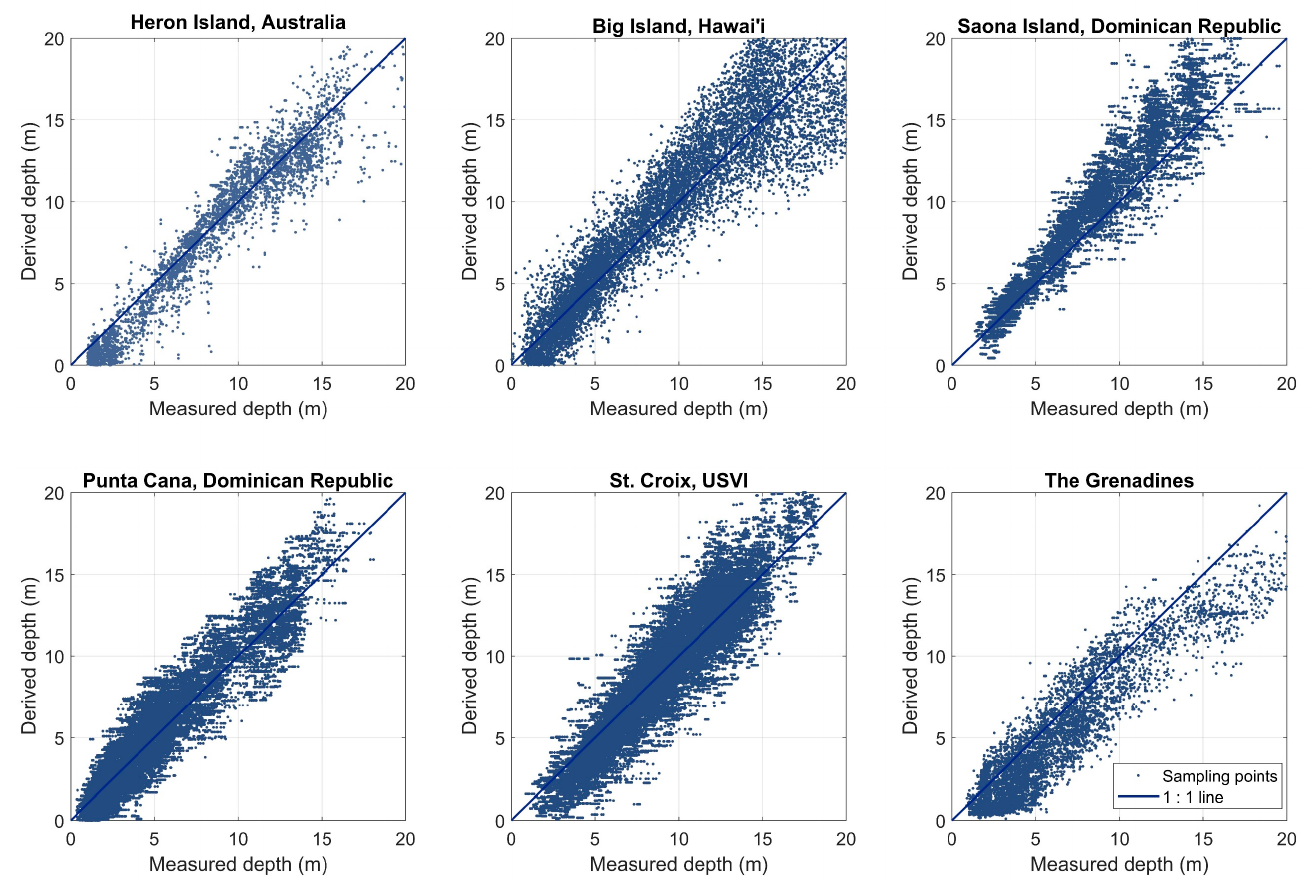
Figure 7. Bathymetry estimation validations using the field measured depth sampling points.